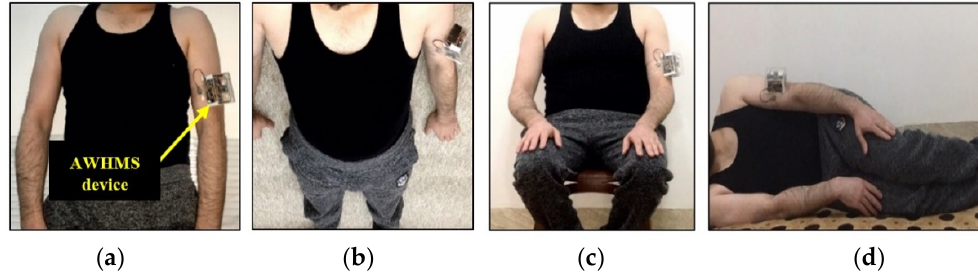
Figure 8. Experimental tests for ( a ) standing up rapidly from a seated position, ( b ) lying on the ground, ( c ) rapidly sitting down on a chair, and ( d ) lying on the side.